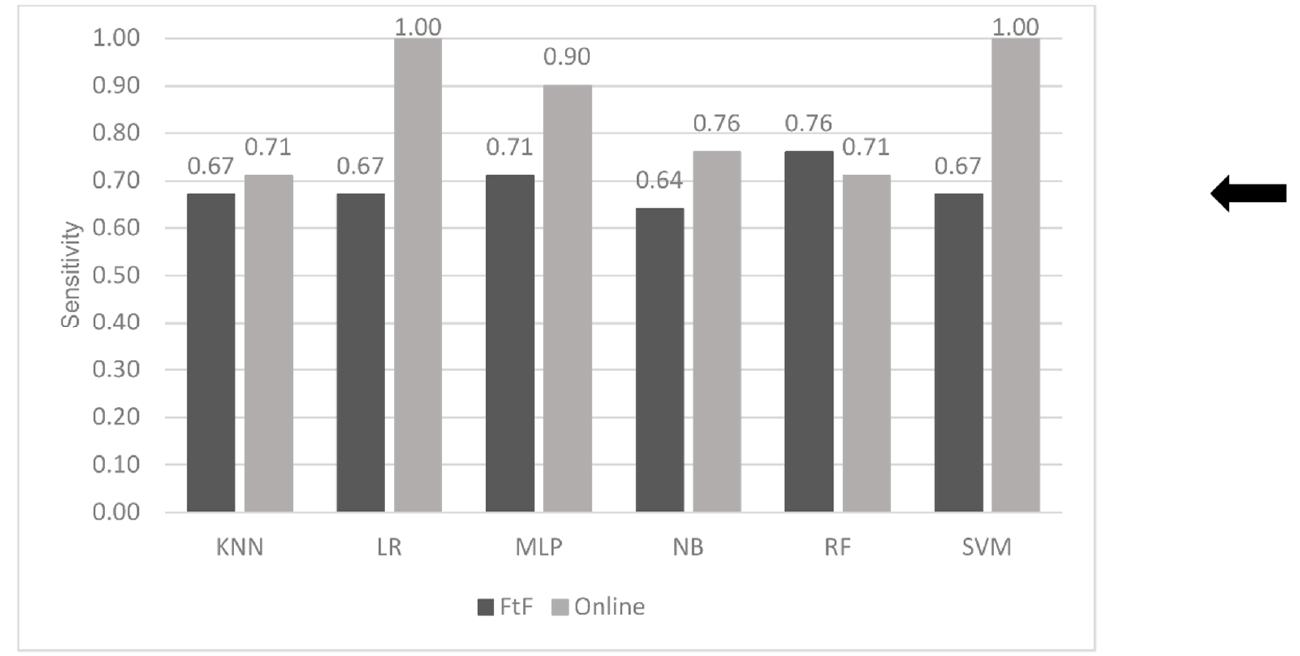
Figure 5. WED course: prediction of at ‐ risk students (sensitivity scores) by instructional mode.